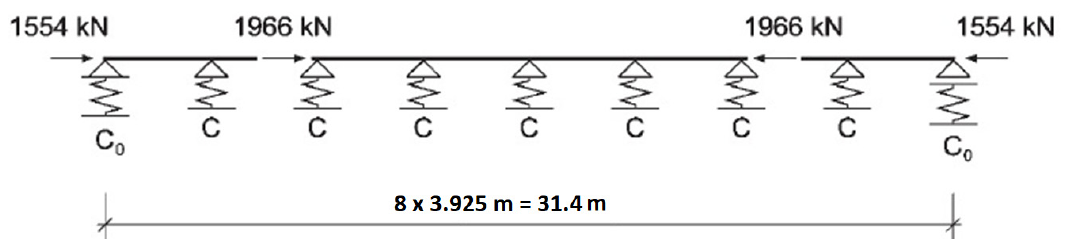
Figure 5. Example 2: description taken from [7] Section 5.5.